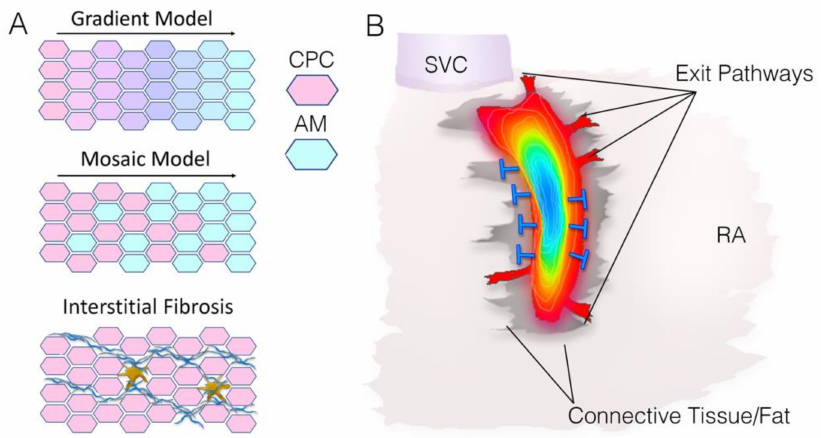
Figure 2. Models of sinoatrial node structure/function. ( A ) Graphical depictions of the Gradient Model, the Mosaic Model, and Interstitial Fibrosis. CPC—cardiac pacemaker cell, AM—atrial myocyte. ( B ) Diagram of sinoatrial node activation pattern (blue to red). Potential exit pathways to the atrial myocardium and connective tissue (grey) that serve as resistive barriers (blue lines) are indicated. SVC—superior vena cava, RA—right